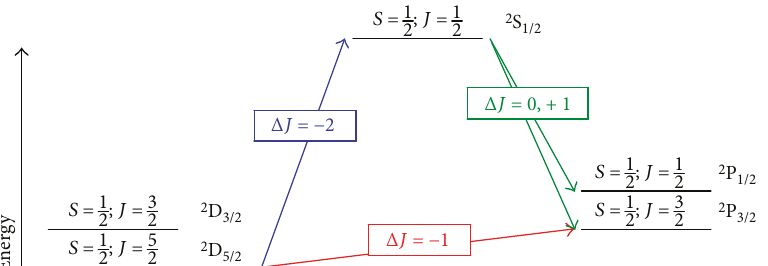
Figure 4: Atomic case: term scheme (with SOC; no crystal fi eld) comparing the two-step (1s XAS, 2p XES) 1s2p RIXS and the one-step 2p XAS pathways for Cu 2+ . The sum over all J multiplicities 2 J + 1 yields the total number of microstates per con fi guration.